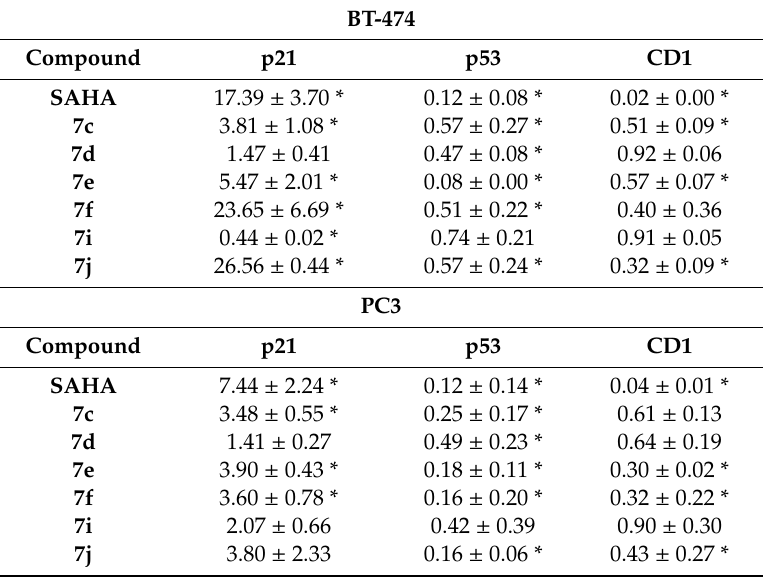
Table 3. The e ff ect of compounds 7a – k , when tested against two cancer cell lines, on the expression of genes related to apoptosis and the cell